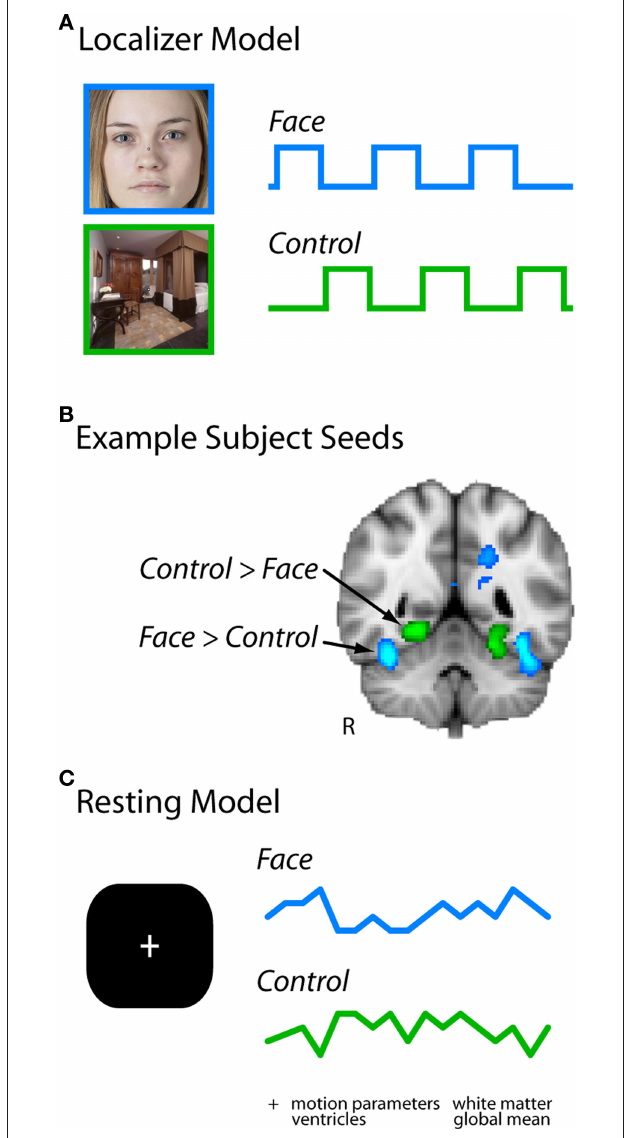
FIguRe 1 | Analysis pipeline. (A) Localizer runs were modeled with regressors for face blocks and control blocks (scenes or flowers in Experiment 1, scenes in Experiment 2). (B) The contrast of these two regressors identified two seed regions in each subject for further investigation: the right fusiform gyrus (FG), and an adjacent region of right ventral temporal cortex selective for flowers or scenes (the latter is the PHC). (C) Timeseries were extracted from these regions in each resting run, and entered simultaneously in a GLM of the same run (along with other nuisance regressors of no